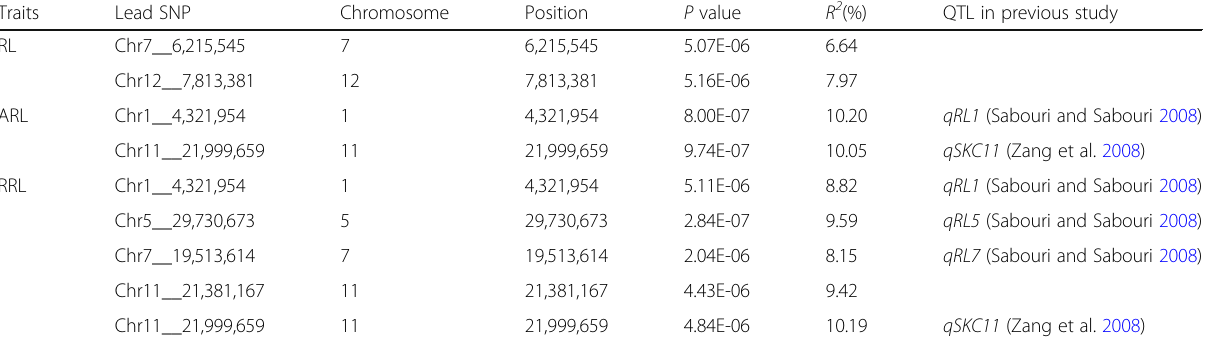
Table 2 Lead SNPs for RL, ARL and RRL identified by GWAS Traits Lead SNP Chromosome Position P value